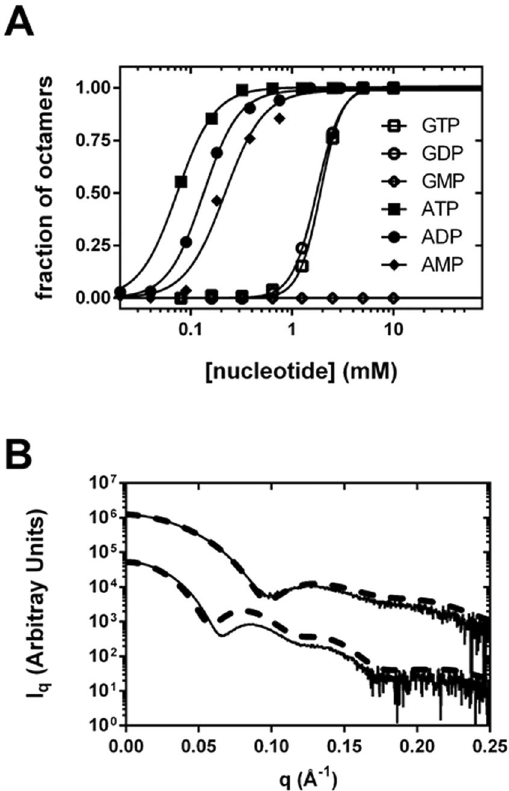
Figure 1. Guanine and adenine nucleotides induce octamers of AgIMPDH with different conformations. ( A ) Fractions of octamers/tetramers of AgIMPDH in solution (4 mg mL − 1 ) at different nucleotide concentrations, as determined by SAXS experiments. ( B ) SAXS profiles of AgIMPDH in in the presence of 5 mM GDP (upper continuos line) and 3 mM ATP (botton continuos line). Identical results were obtained for GTP and GDP, as well as for ATP, ADP and AMP (not all curves are shown here to facilitate visualization). The thick dashed lines show the theoretical SAXS profiles calculated from the crystallographic structures fitted to the experimental ones. The SAXS profiles have been conveniently displaced along the y-axis to facilitate